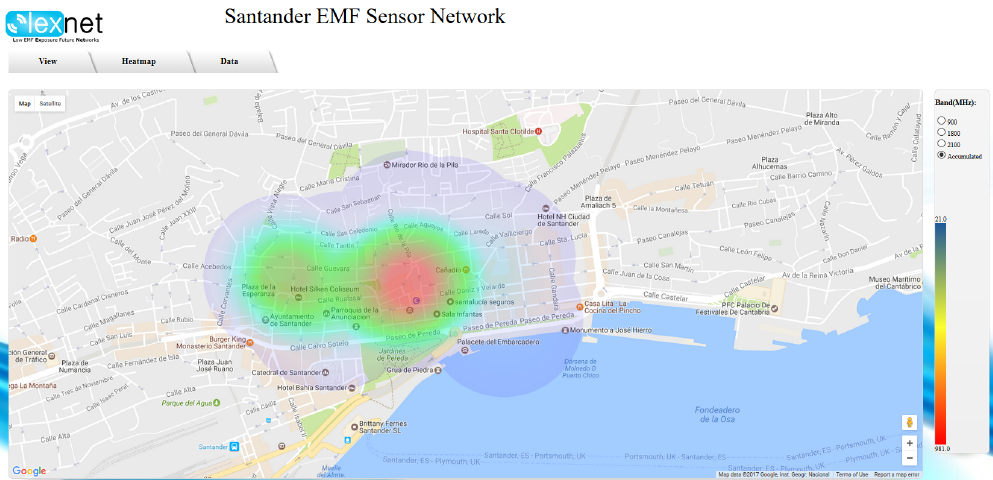
Figure 7. Heat map of the EMF exposure on Santander